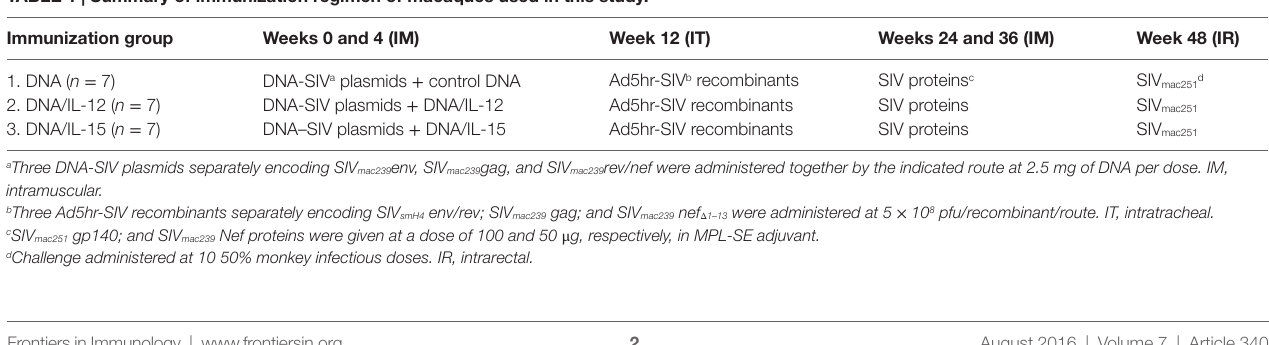
TaBle 1 | summary of immunization regimen of macaques used in this